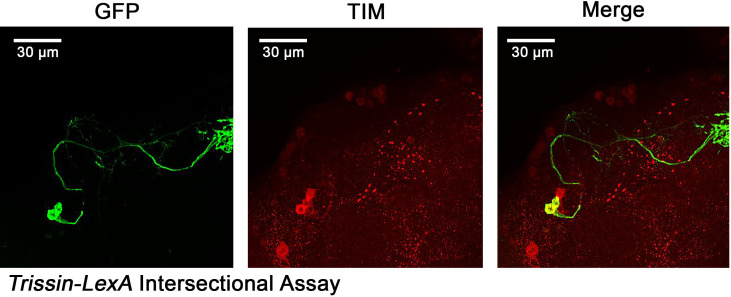
Identification of two Trissin-expressiong LNd neurons.Confocal stack of images showing antibody staining for GFP and TIM in Trissin-LexA > LexAop-FLP; Clk856-GAL4 > UAS-FRT-STOP-FRT-Cschrimson.venus fly brains. GFP (left), TIM (middle), and a merge of these two images (right). Only two LNds neurons in the clock network express Trissin.